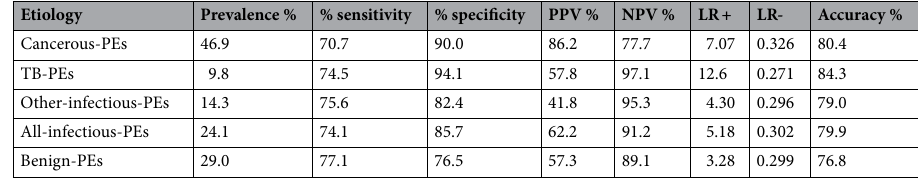
Table 3. Diagnostic performance of classifier with sensitivity/specificity cut-offs selected at the maximal J-index and taking the etiology prevalence into